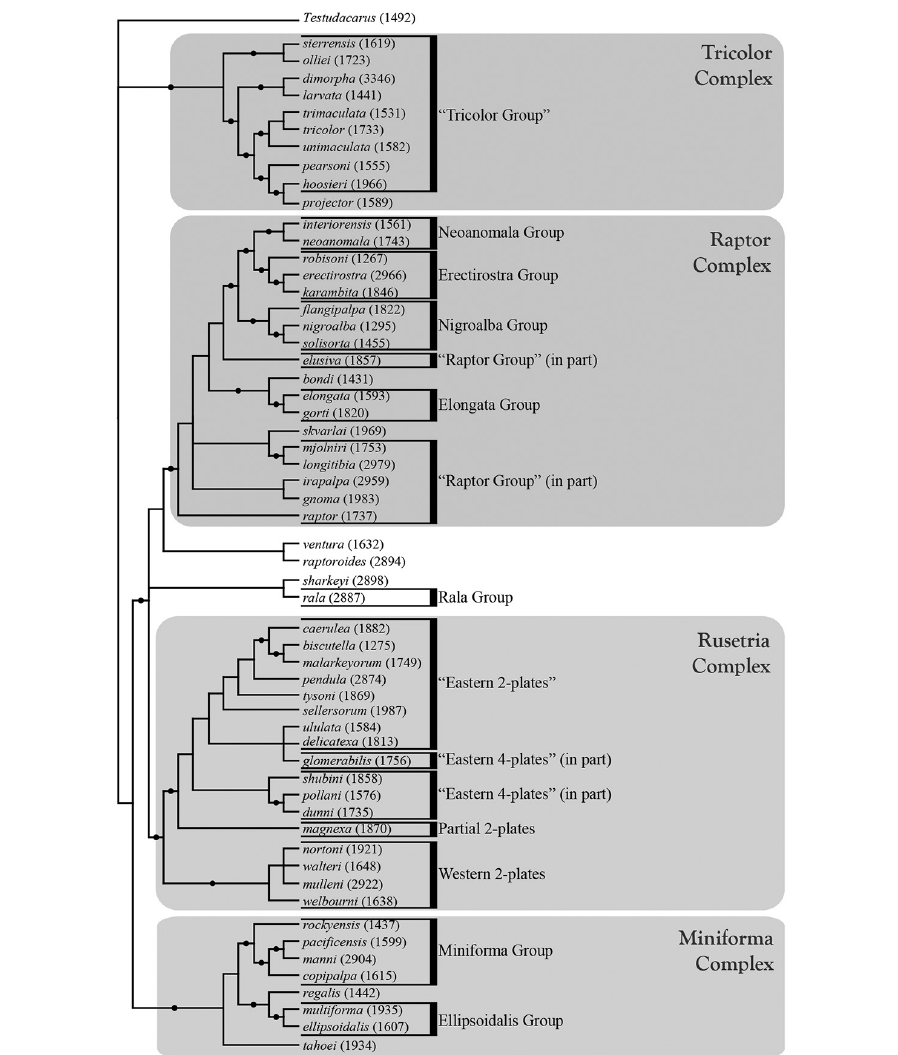
Figure 7. Bayesian inferred cladogram for combined analysis (28S+COI) of North American Torrenti- cola : species complexes and identification groups. Four well-supported complexes are organized into 13 groups that are helpful for identification. Note that 1) not all identification groups are monophyletic (in quotation marks); 2) not all species are placed in a complex; and 3) some species are not placed within a group, reflecting their identification difficulty. Numbers are DNA identification numbers. Dots denote posterior probably